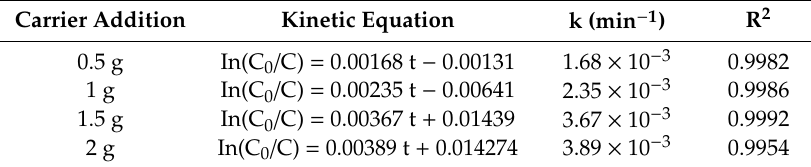
Table 4. The reaction kinetics parameters of photocatalytic of MB with di ff erent dosage.